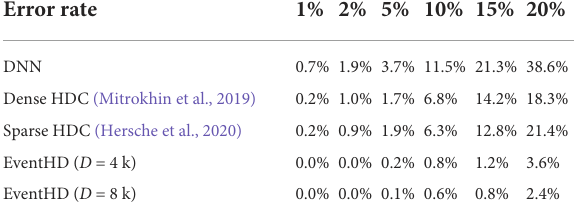
TABLE 1 Robustness analysis of different learning algorithms to hardware error